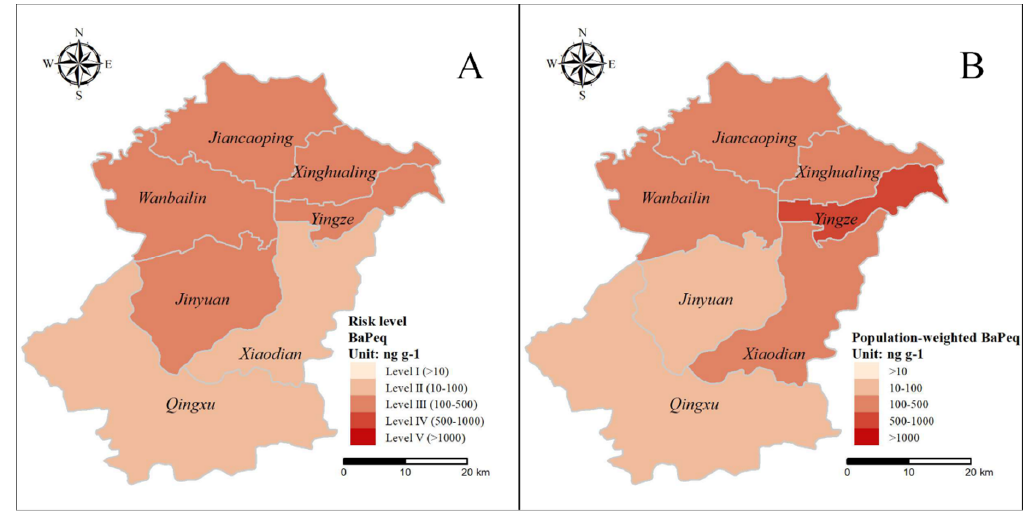
Figure 7. (A) Spatial distributions of risk level and ( B ) population-weighted BaP eq in soils. Figure 7. ( A ) Spatial distributions of risk level and ( B ) population-weighted BaP eq in